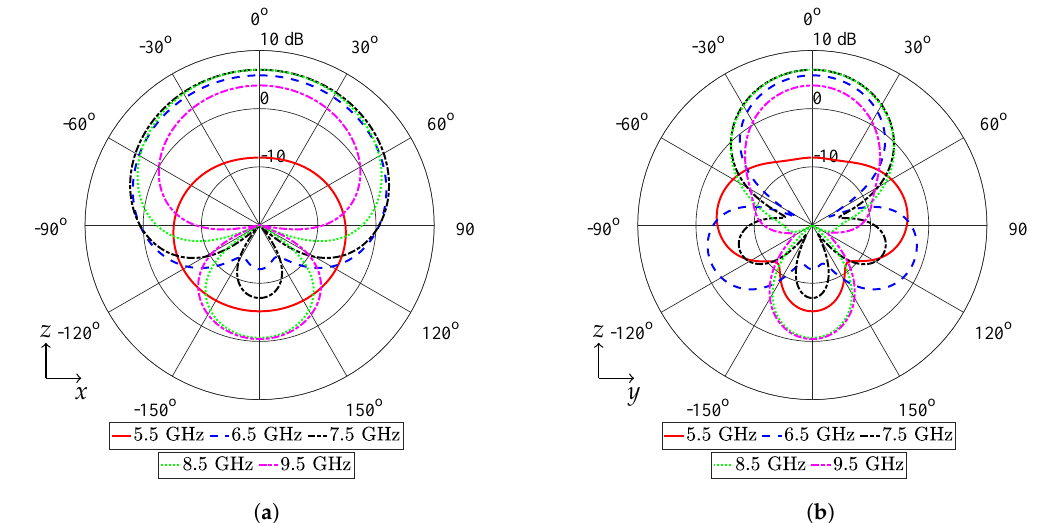
Figure 11. Antenna III ( a ) Realized gain in the xz plane ( φ = 0). ( b ) Realized gain in the yz plane ( φ = 90). The maximum cross-polarization level is less than 49dB and 41dB for φ = 0 and φ = 90, respectively.